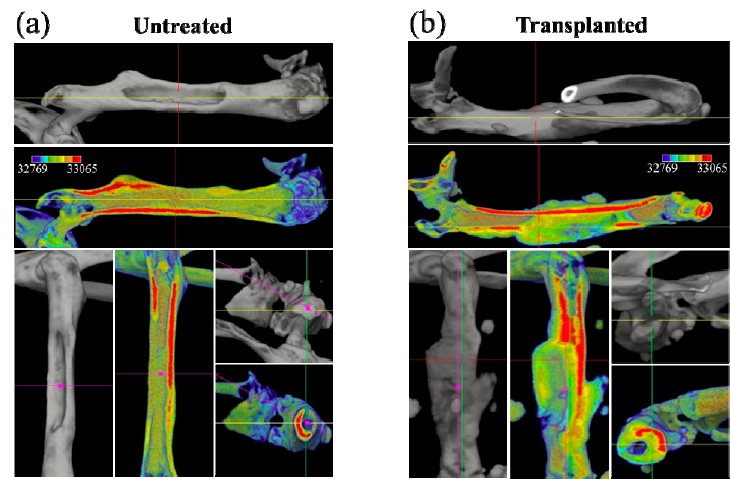
Figure 2. Color scale on μ CT 3D views for untreated ( a ) and transplanted ( b ) femurs; red and blue colors represent the highest and lowest bone density, respectively.